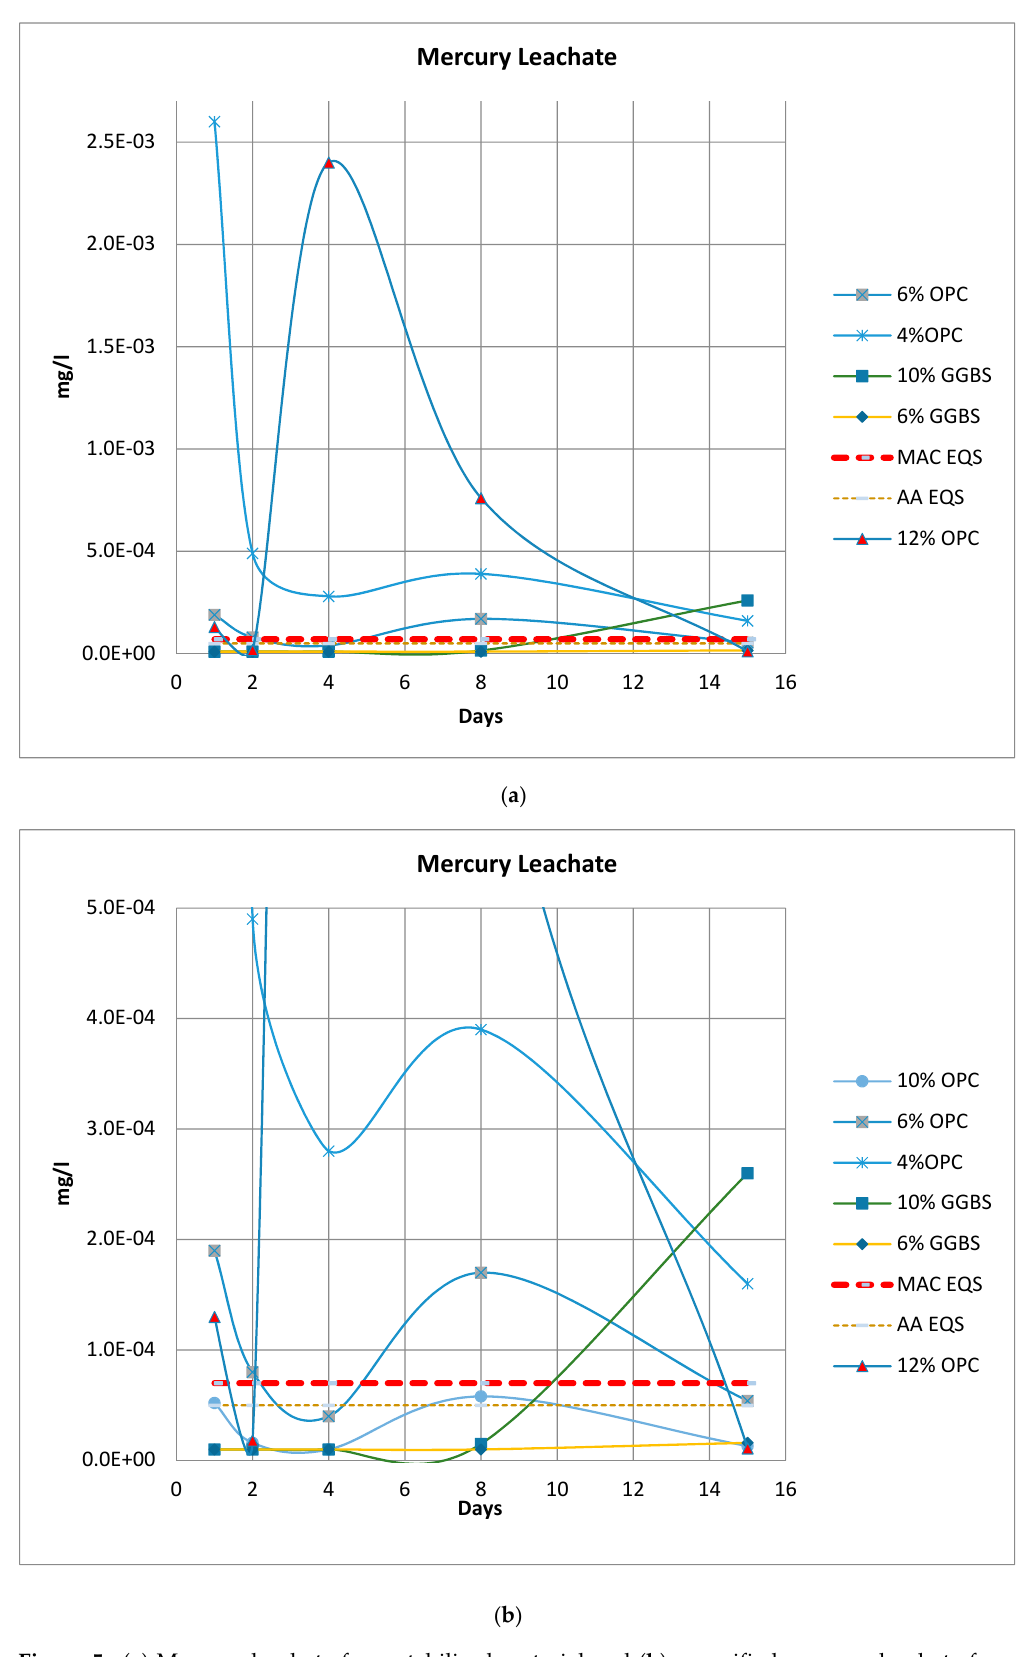
Figure 5. ( a ) Mercury leachate from stabilised material and ( b ) magnified mercury leachate from stabilised